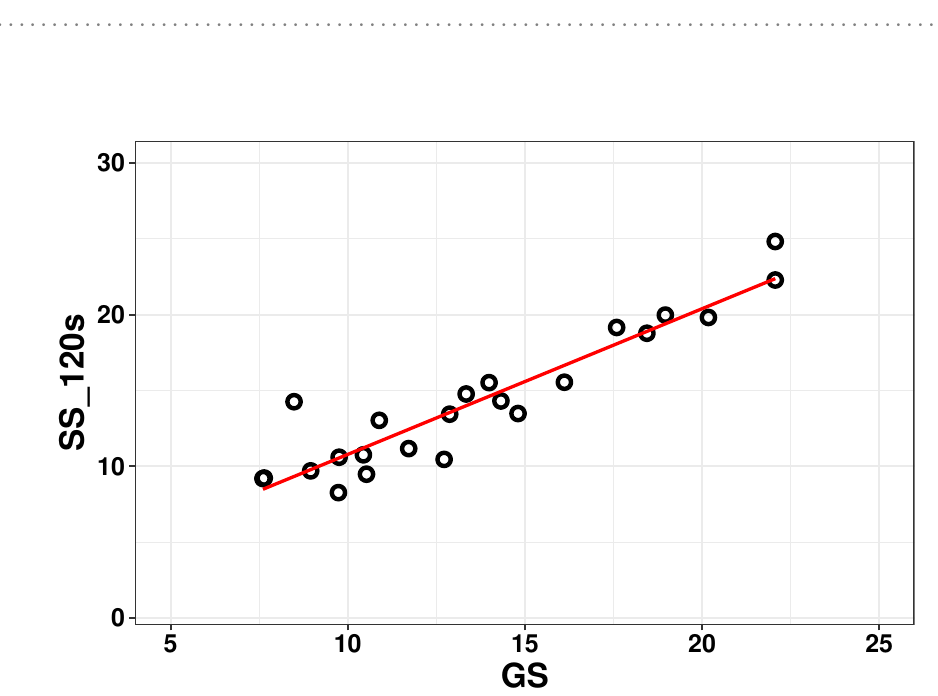
Figure 9: Correlation analysis of GS vs SS 120 s of the SS index, rho = 0 . 90 , p = 3.28e-06.